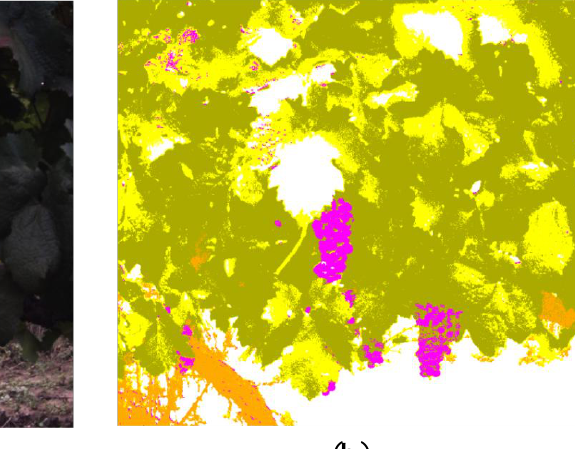
Figure 13. ( a ) Original RGB image—scene 4; ( b ) Clustered image—scene 4; ( c ) Original RGB image—scene 5; ( d ) Clustered image—scene 5; ( e ) Original RGB image—scene 6; ( f ) Clustered image—scene